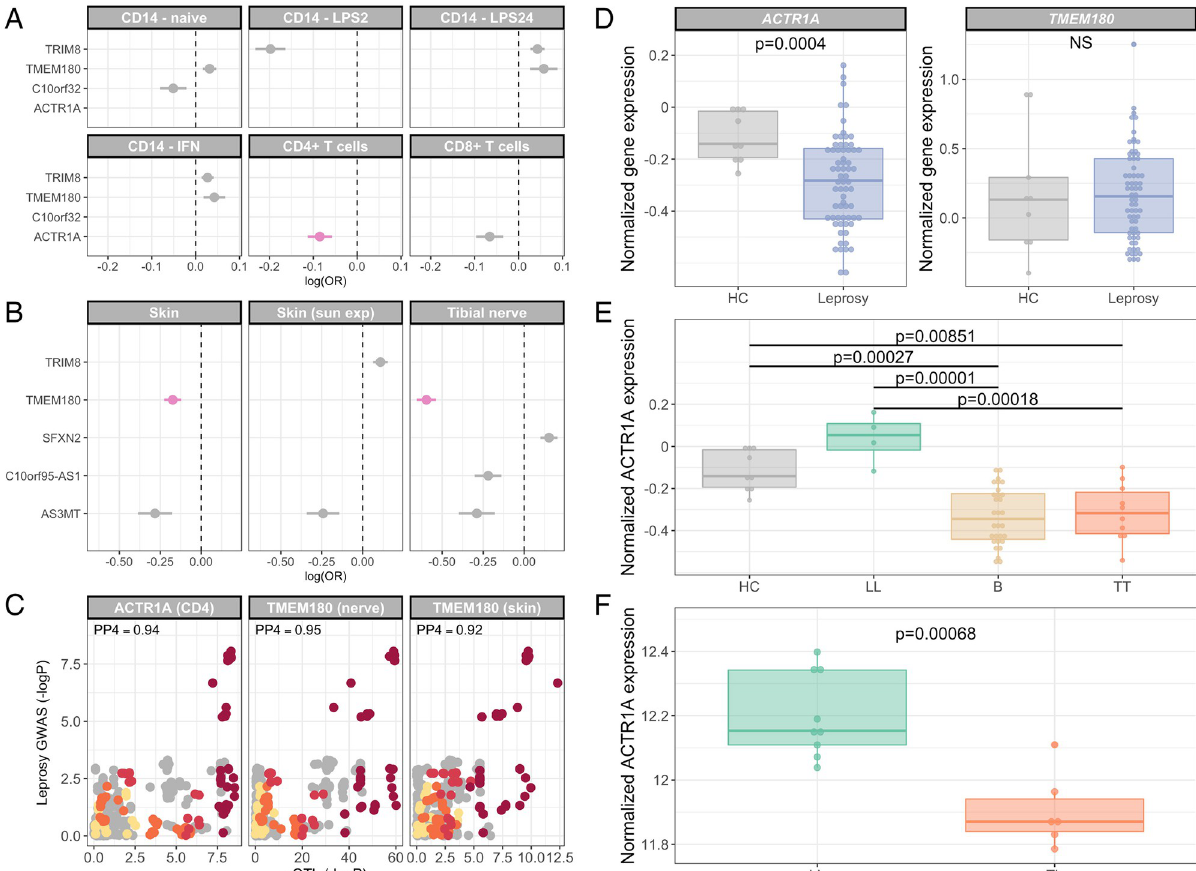
Fig 3. ACTR1A and TMEM180 are candidate mediators of leprosy susceptibility at chromosome 10q24.32. (A) Association of rs2015583:G genotype with gene expression in primary immune cells. Associations for which there is evidence of a shared causal variant with the leprosy association are highlighted (pink). (B) Association of rs2015583:G genotype with gene expression in skin (sun exposed and unexposed) and peripheral nervous tissue (tibial nerve). Associations for which there is evidence of a shared causal variant with the leprosy association are highlighted (pink). (C) Evidence for colocalisation of the leprosy association signal at chr10q24.32 with ACTR1A expression in CD4 + T cells and TMEM180 expression in skin (sun unexposed) and peripheral nerves. SNPs are coloured according to linkage disequilibrium to rs2015583 as above. PP4, posterior probability of signal colocalisation. (D) ACTR1A and TMEM180 expression in skin biopsy samples from healthy controls (HC, n = 9) and skin lesions from leprosy patients (n = 67) from the Belone et al microarray data [22]. (E) ACTR1A expression in skin biopsy samples from healthy controls (HC, n = 9) and skin lesions from leprosy patients with lepromatous (LL, n = 4), tuberculoid (TT, n = 10) and borderline (B, n = 30) disease from the Belone et al microarray data [22]. (F) ACTR1A expression in skin biopsy samples from leprosy patients with lepromatous (LL, n = 9) and tuberculoid (TT, n = 6) disease from the Montoya et al dataset [23]. P-values for comparison of two groups were derived with t-tests (normally distributed data) or Mann-Whitney tests (non- normally distributed data). Comparison of expression across multiple groups was performed by ANOVA, with subsequent pairwise testing with Tukey’s HSD